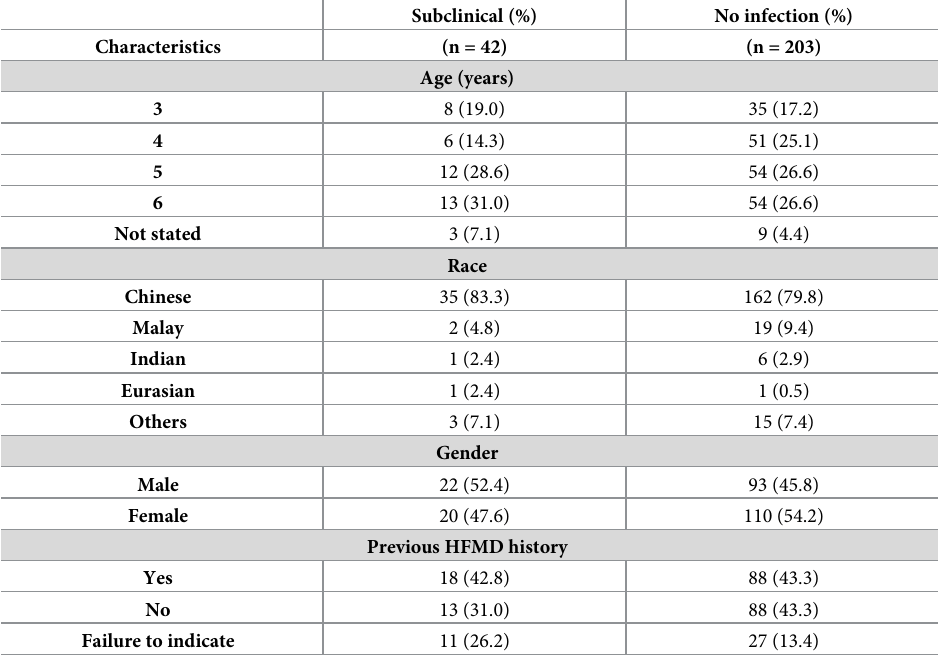
Table 2. Comparison of the socio-demographic characteristics among healthy children volunteers. Parameters such as age, race, gender and previous HFMD history were collected based on recall from our questionnaire. A total of 245 children without signs and symptoms indicative of HFMD at the point of sample collected was recruited. Based on the Pan-Entero RT-PCR assay established previously using clinical samples, we stratified the children according to presence or absence of subclinical infection to identify possible risk factors associated with